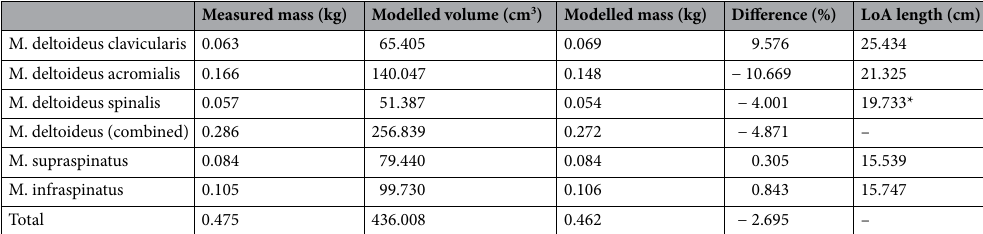
Table 3. Comparison between measurements and muscle masses calculated from the 3D models for the gorilla. The length of the muscle was measured along the LoA (arc length) of the modelled muscles and represents the length from origin to insertion and thus the total length of the muscle tendon unit (MTU). *Note the length of the M. deltoideus spinalis was exaggerated due to the kink in the LoA estimation (see Fig. 3d).